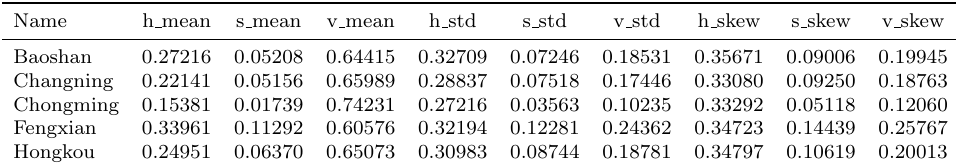
Table 5: Partial colour features identified in